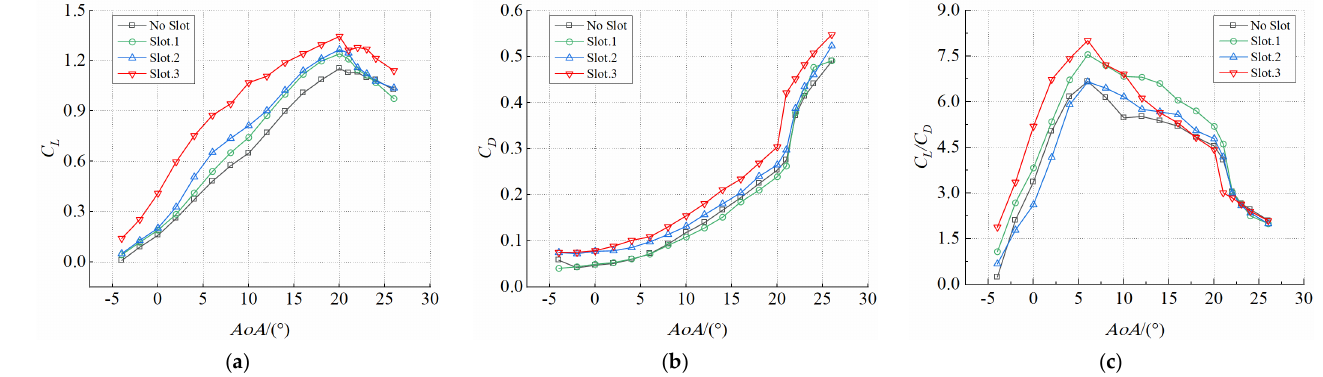
Figure 9. Aerodynamic curve of wing with each slot independently blown ( U ∞ = 8 m/s, Q = 27.94 m 3 /h). ( a ) Lift coefficient. ( b ) Drag coefficient. ( c ) Lift-to-drag ratio.